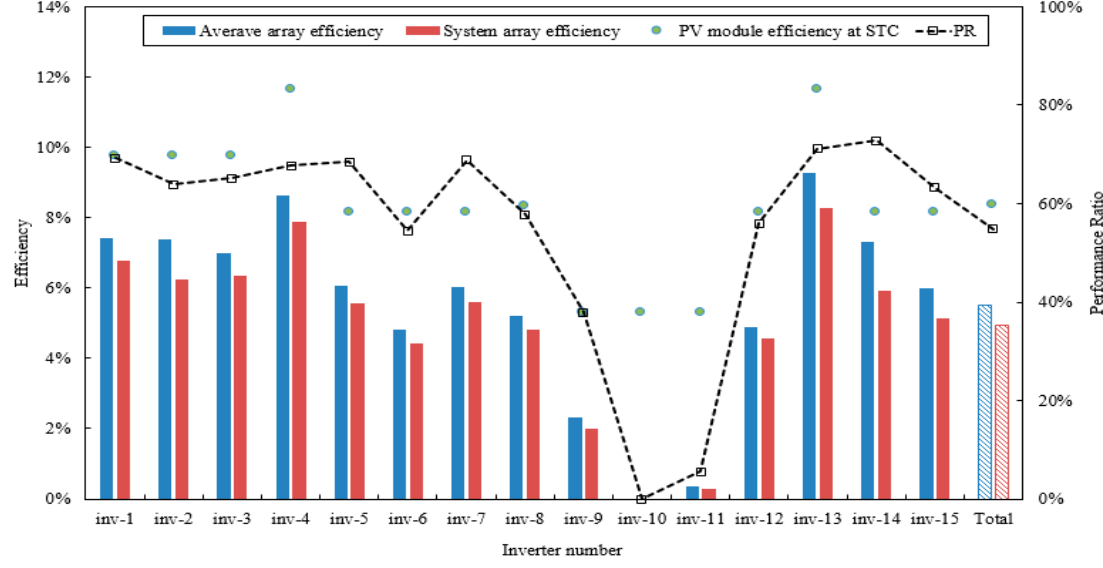
Figure 13. PV power generation efficiency and PR by 2017.